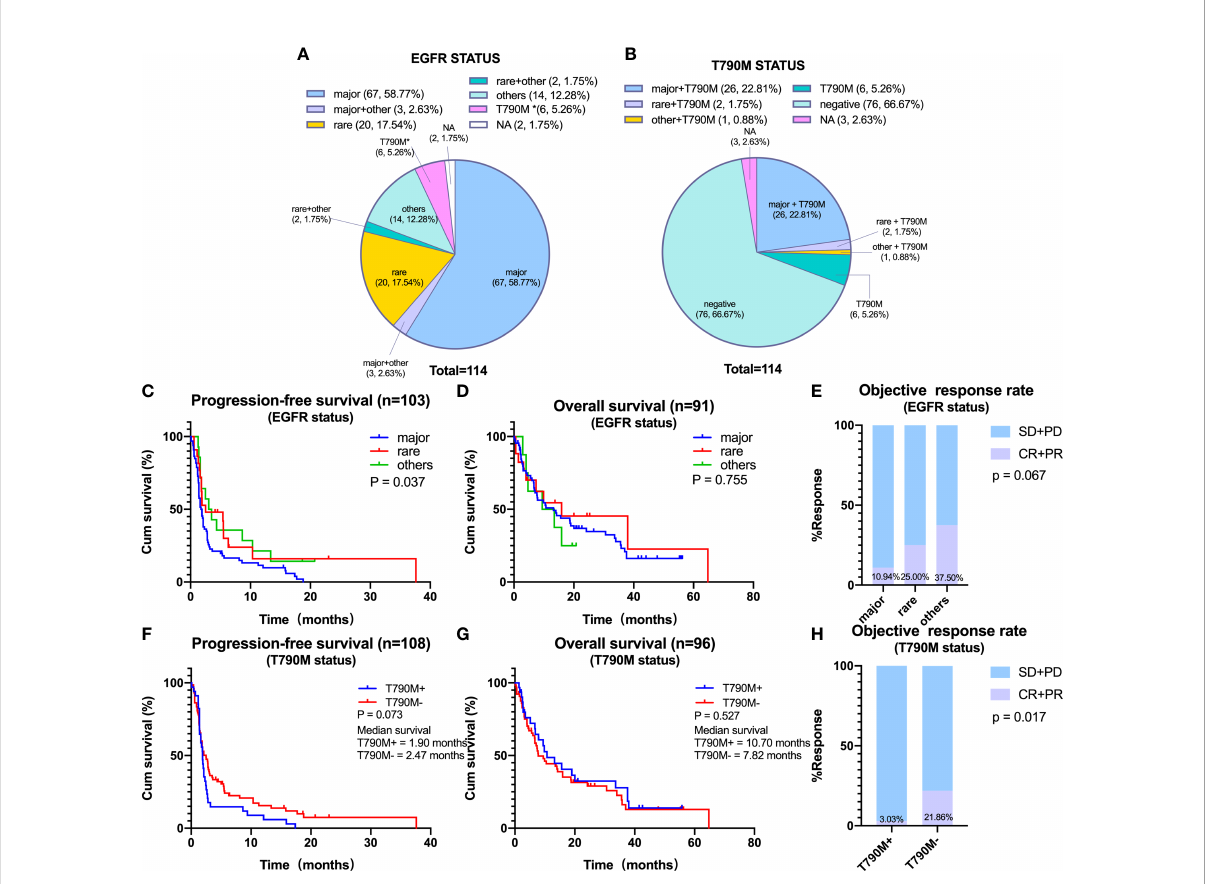
FIGURE 2 Ef fi cacy of immune checkpoint inhibitors on distinct epidermal growth factor receptor (EGFR) subtypes. (A) Percentage of patients with non- small cell lung cancer containing major, rare, and other EGFR mutations. Major EGFR mutations include L858R and 19Del, and rare mutations include 20ins and G719X. (B) Percentage of patients according to T790M status. (C – E) Progression-free survival (PFS) (C) , overall survival (OS) (D) , and objective response rate (ORR) (E) in patients harboring major, rare, or other EGFR mutations. (F – H) PFS (F) , OS (G) , and ORR (H)